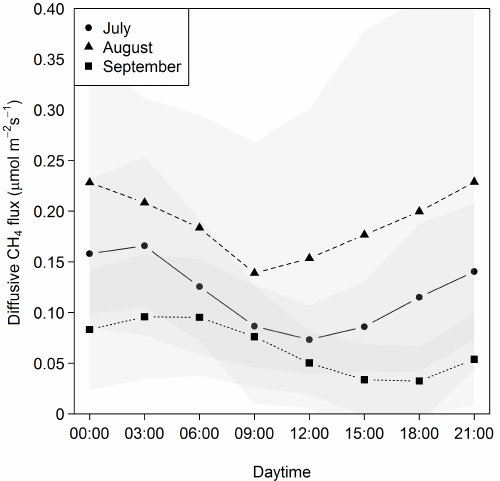
Figure 7. Monthly averaged diurnal cycle of diffusive CH 4 fluxes indicating differences in magnitude and amplitude as well as a shift in minimum and maximum daily CH 4 fluxes over the course of the study period.